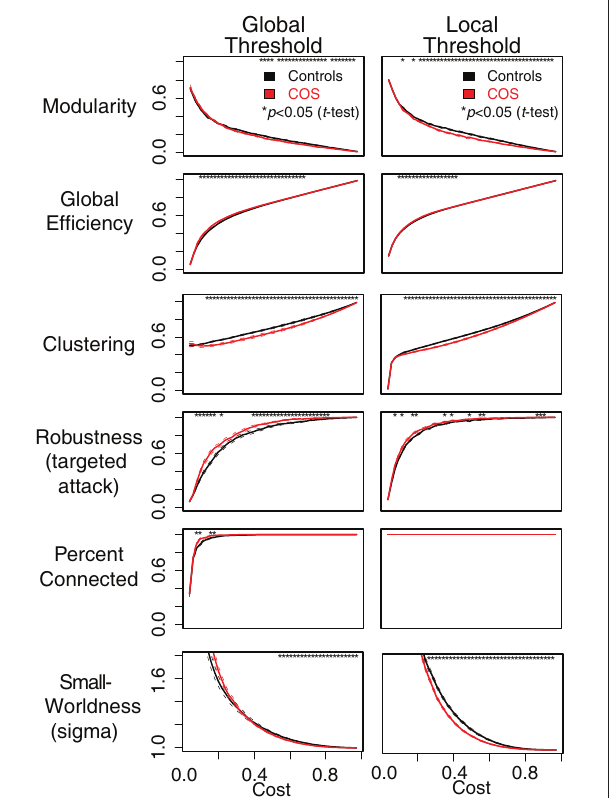
FIguRe 3 | Plots showing differences between the schizophrenic patients (red) and the controls (black) in terms of the graph theoretical properties of the brain networks, which have been constructed using local and global thresholding methods. The two methods produce a similar pattern of group differences. However, local thresholding ensures connected graphs and appears to be more sensitive to group differences in some complex network metrics. The six different graph theoretical measures are shown as a function of connection density or topological cost, which is the proportion of edges included. Error bars are standard mean error, and asterisks signify an uncorrected p < 0.05 for a t -test between the COS population and control population.